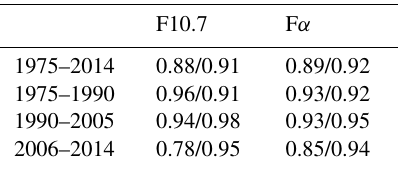
Table 1. Percentage of total variance of yearly values of fo E ac- counted for by solar activity proxies (Eq. 1) for the whole period and for three sub-periods, for Juliusruh and Chilton (values sepa- rated with a